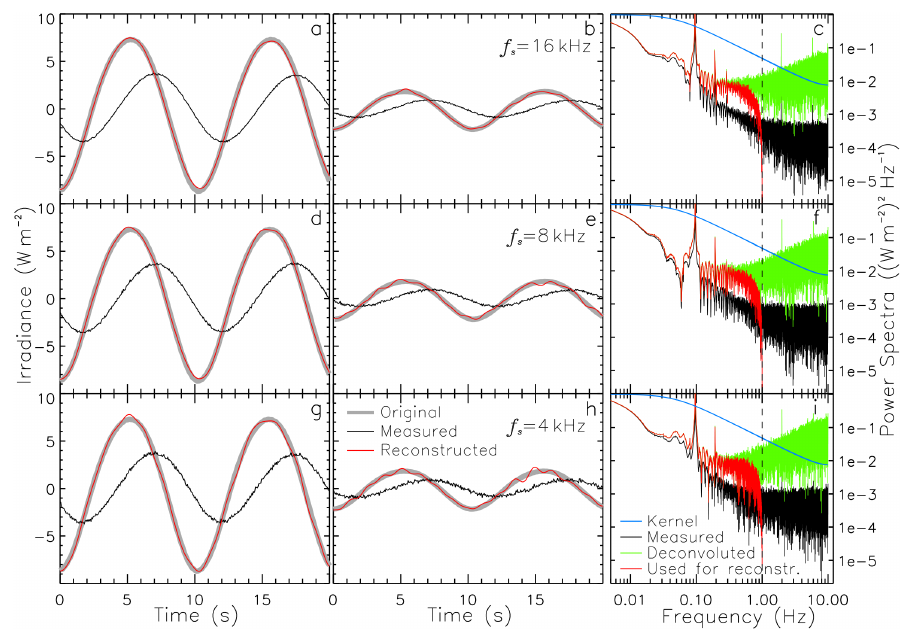
Figure 4. Measured (black) and reconstructed irradiance (red) in case of a periodic oscillating time series (gray) for three different sampling frequencies f s = 16/8/4kHz. Oscillations with two different amplitude were generated, 8Wm − 2 amplitude in the left panels ( a , d and g ) and 2Wm − 2 amplitude in the center ( b , e and h ). The corresponding power spectra for the measured (black), deconvoluted (green) and reconstructed time series (red) as well as the convolution kernel (blue) are given in ( c , f and i ).